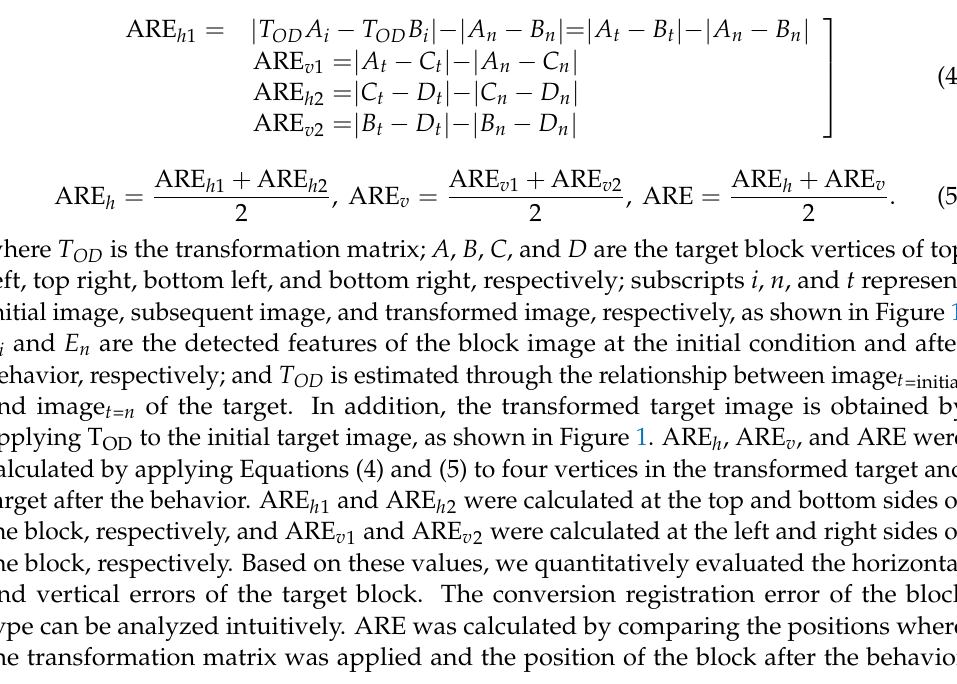
Figure 1. Example of features and vertices to determine TRE and ARE. Different features may be extracted and matched depending on the type of feature detector and descriptor. Thus, the features may not be extracted and matched at the desired location, such as vertices, and it is difficult to quantify the registration error for the block shape with TRE. Therefore, ARE must be used to calculate the registration error for the block shape based on locations of vertices. All vertices were manually selected to exactly represent the block shape. The derivation of the ARE is given by Equations (4) and